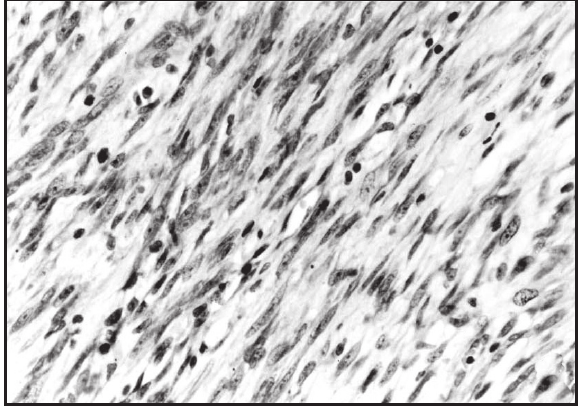
Figura 2 – Caso 1/H.E. Pleomorfismo nuclear moderado com cromatina dispersa em forma de charuto e intenso hipercromatismo (200x)